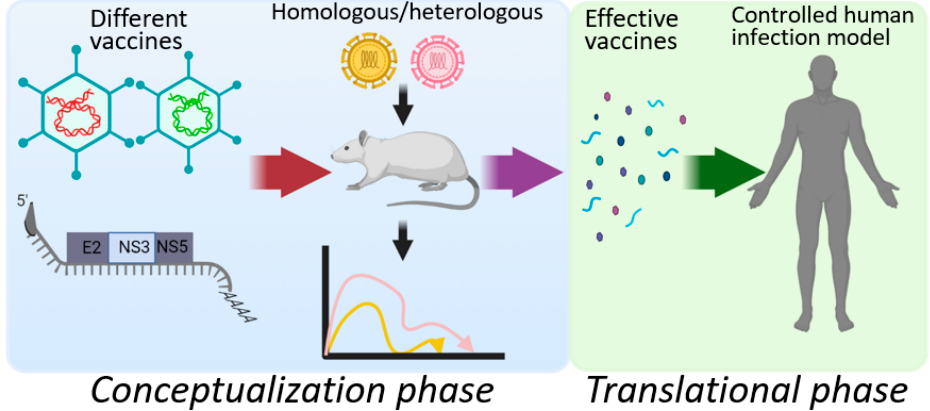
Figure 1. A rational approach to HCV vaccine development and testing.